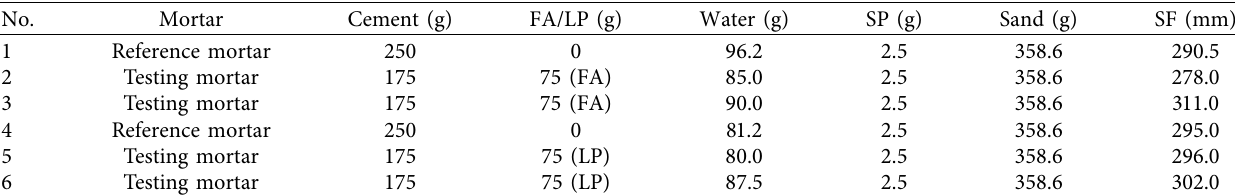
Table 2: Mortar results for the equivalence coefficients of FA and